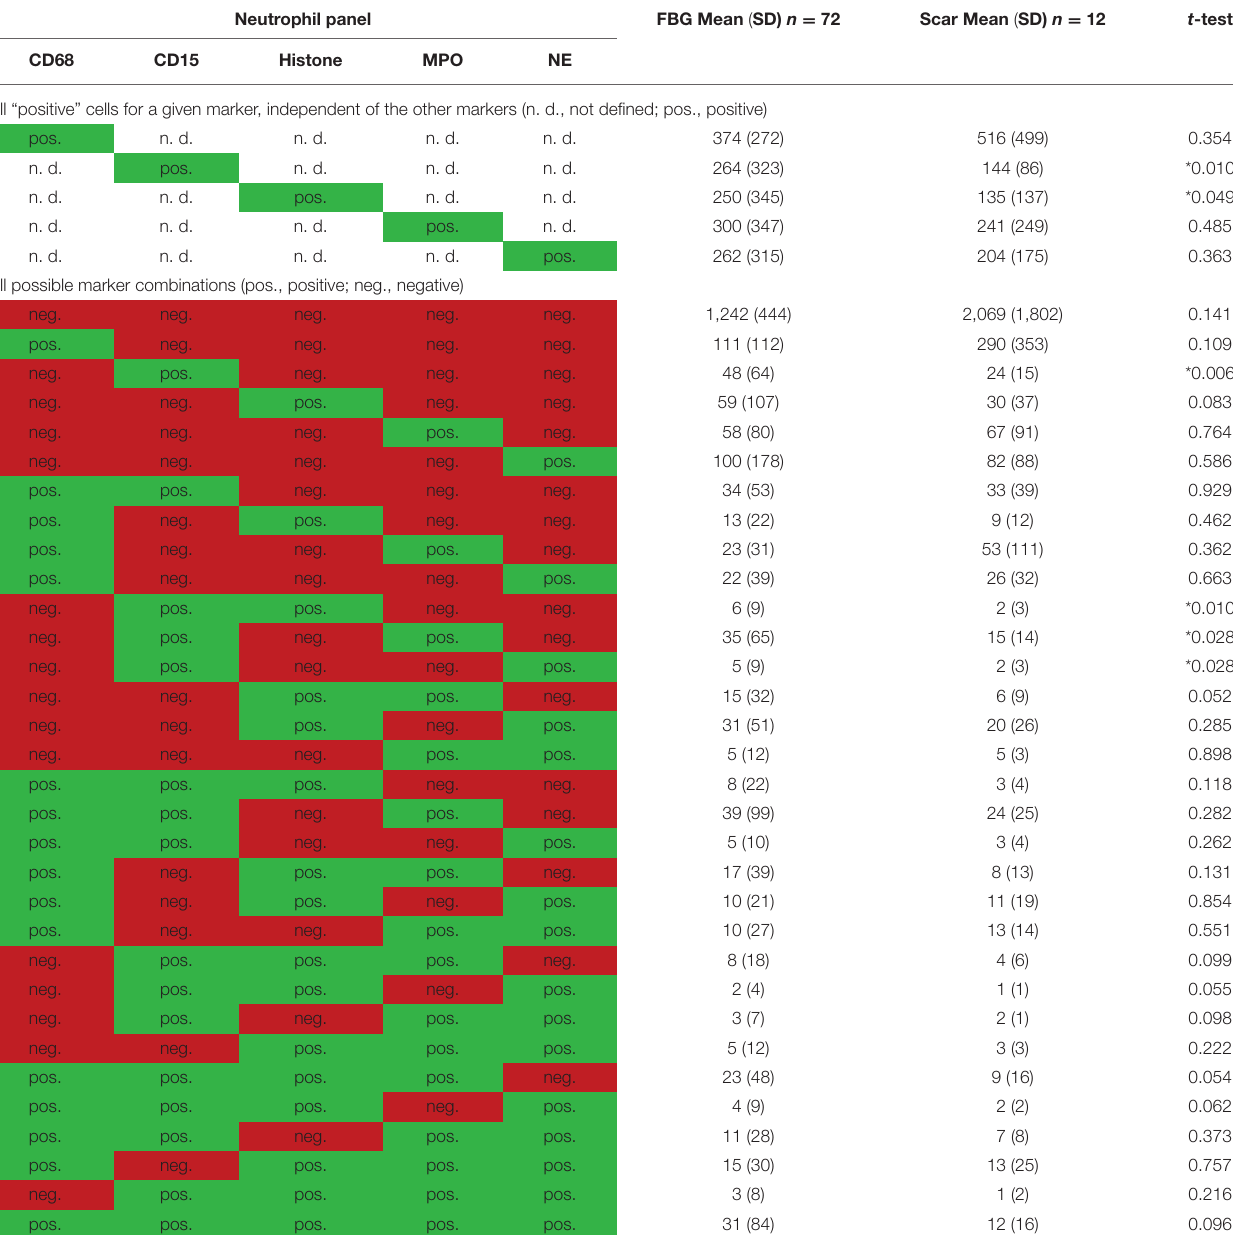
TABLE 5 | Comparison of cells located in the FBG and in the scar tissue by means of the neutrophil panel. Neutrophil panel CD68 CD15 Histone MPO